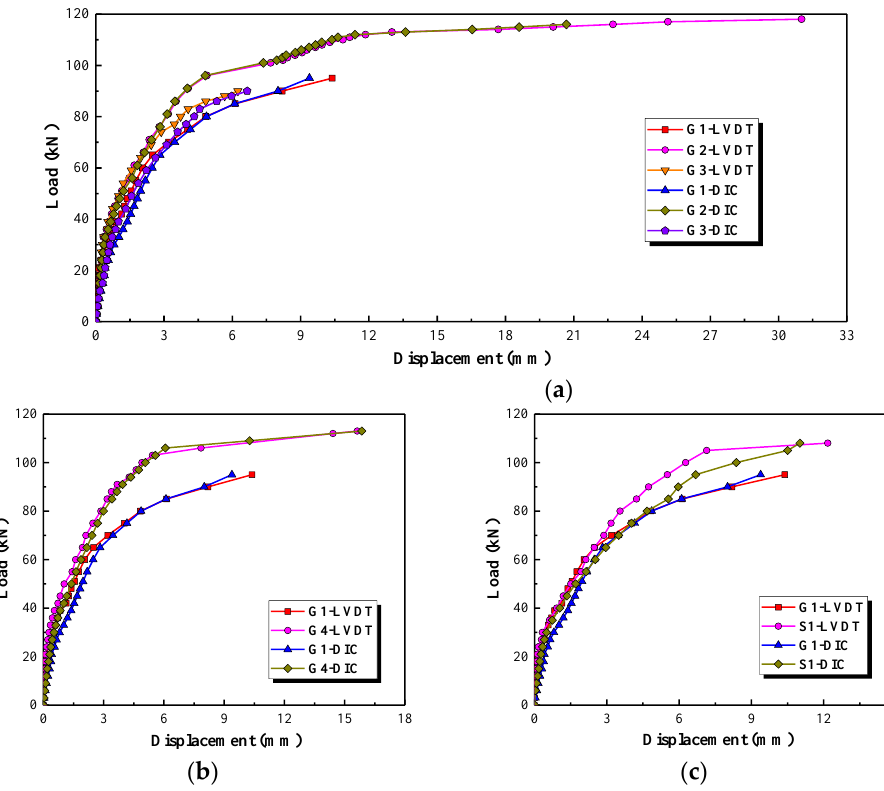
Figure 12. The effect of three parameters on the load-displacement curves. ( a ) Stirrup reinforcement ratio; ( b ) Longitudinal reinforcement ratio; ( c ) Type of stirrups.